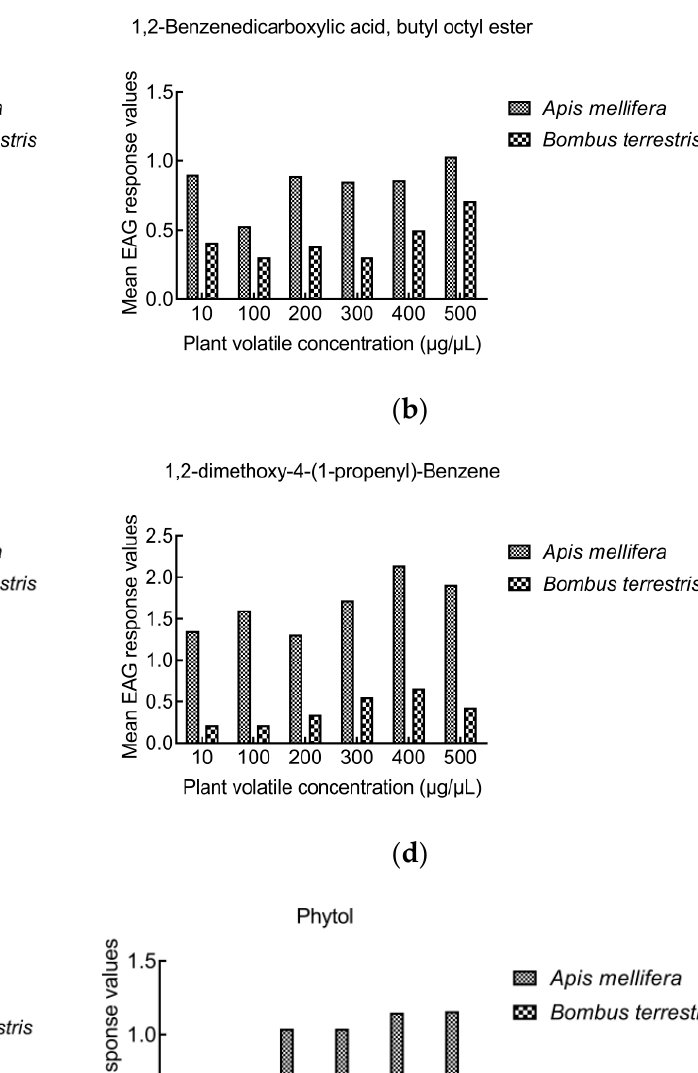
Figure 2. Comparison of EAG responses between A. mellifera and B. terrestris . The rEAGs of B. ter- restris higher than those of A. mellifera : ( a ) 2,5-dimethyl-benzaldehyde, ( b ) e-2-octenal, ( c ) ben-